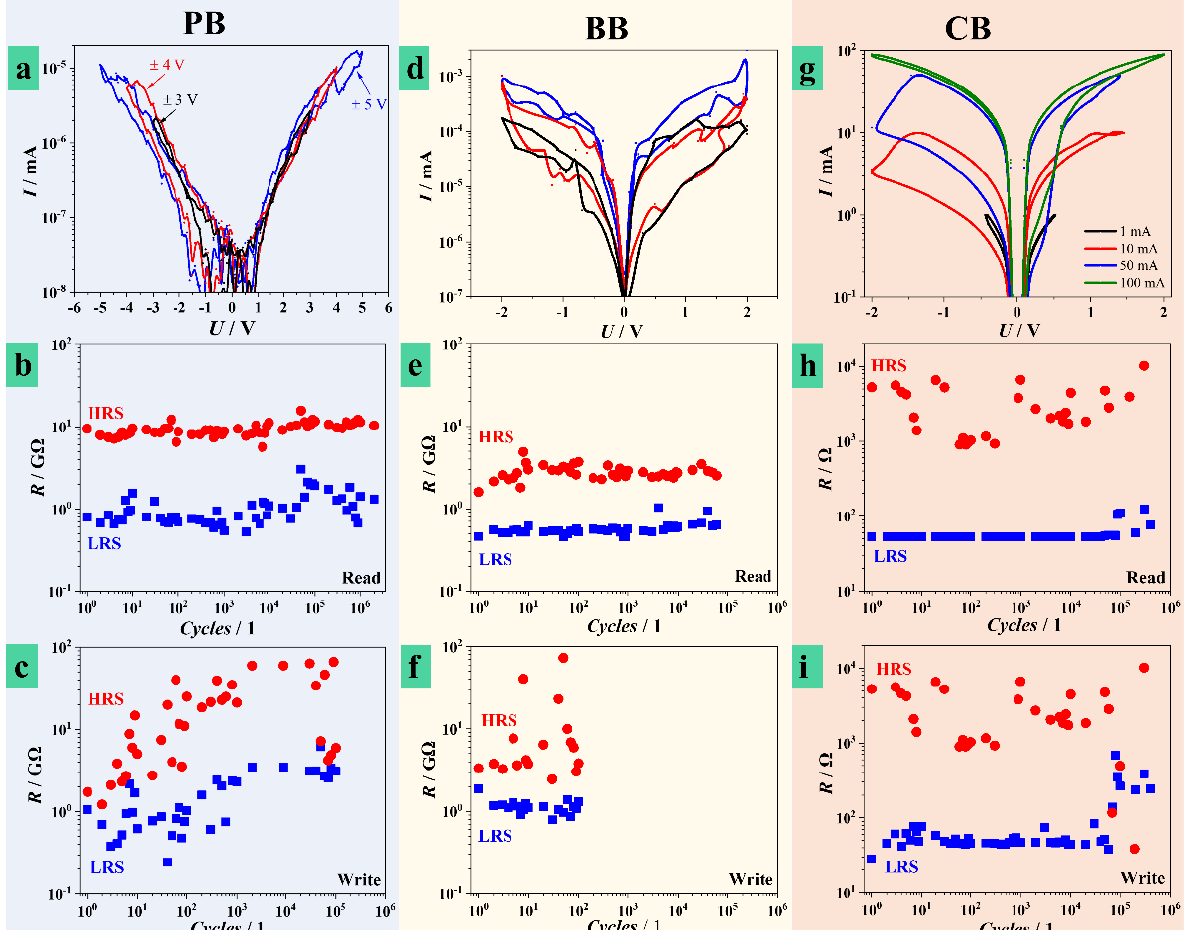
Figure 3. Memristor formation curves together with retention and endurance tests (read/write) for anodic devices grown in PB ( a – c ), borate (BB) ( d – f ), and citrate (CB) ( g – i ) electrolytes.